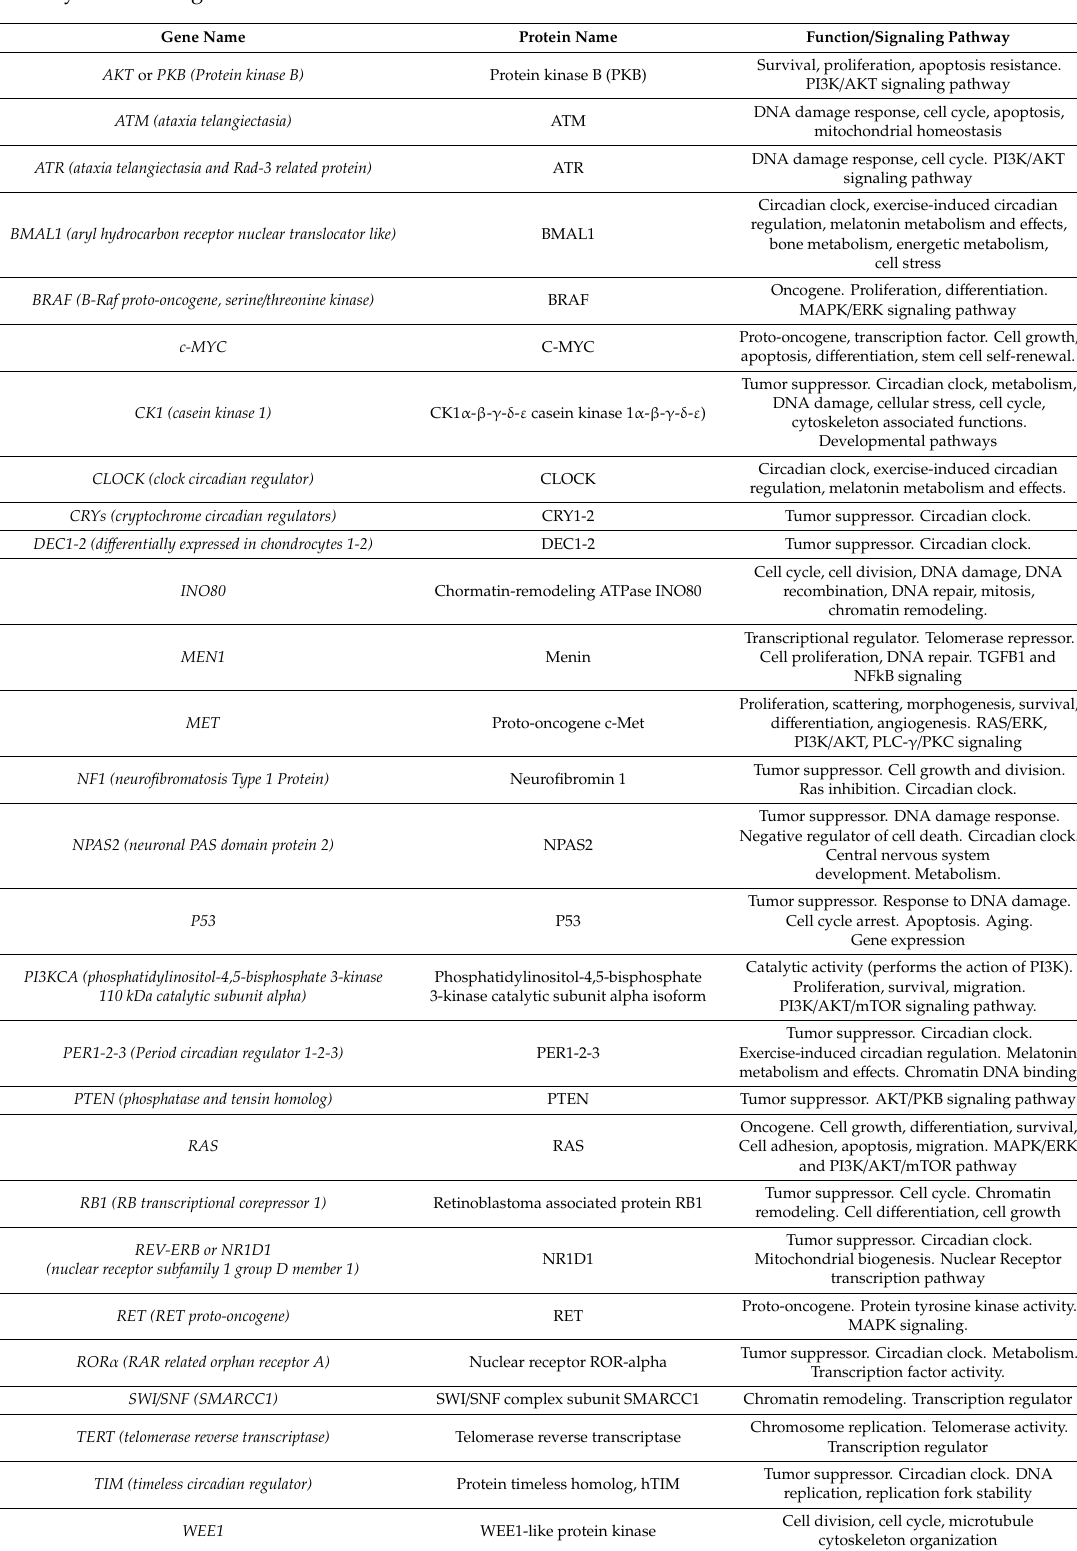
Table 1. List describing in alphabetic order name, major putative functions / signaling pathways of genes and corresponding products involved in circadian clock machinery regulation and thyroid